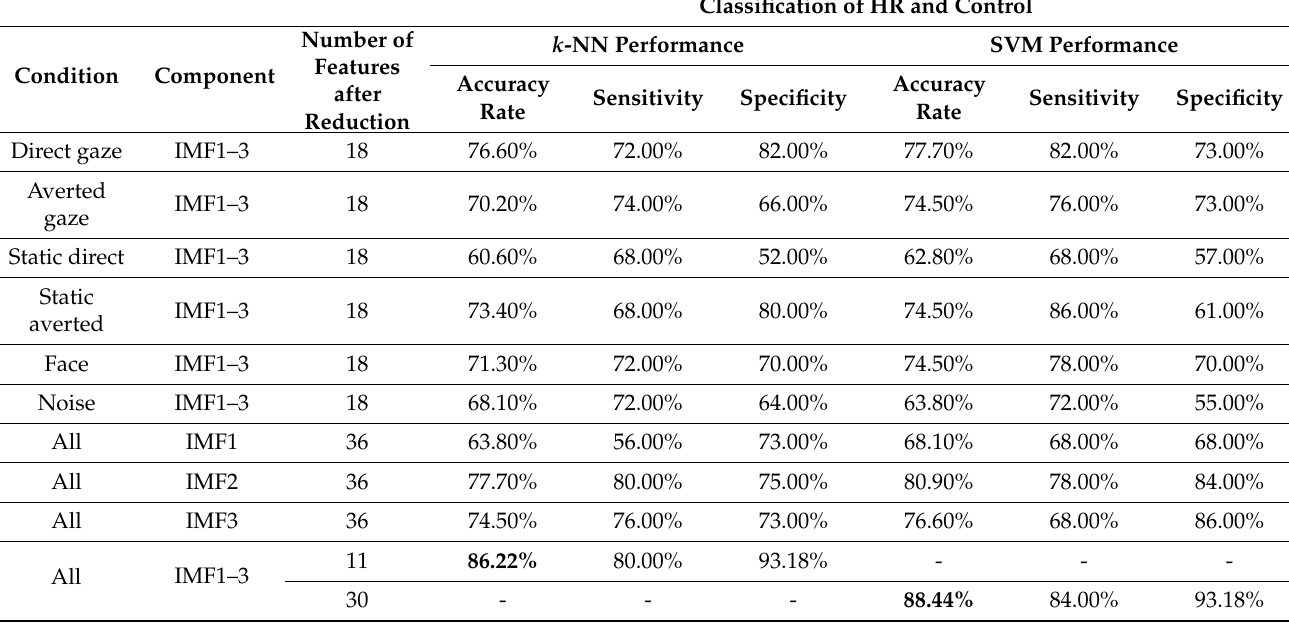
Table 2. For the classification of high-risk and low-risk groups: comparison between k -NN and SVM classifiers of accuracy rates, specificity, and sensitivity. The first six rows represent the results of analysis of the six stimulus conditions separately. Rows 7, 8, and 9 show the classification performance when using features extracted from one IMF at a time. Row 10 represents the results of analyzing the six stimulus conditions together with the IMFs when features were selected by weight correlation and used as input to classifiers: using k -NN, the best performance of 86.22% is obtained with 11 features, and using SVM, the best performance of 88.44% is obtained with top 30 features.